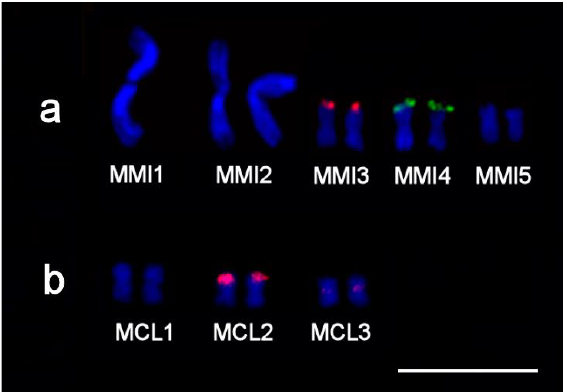
Figure 6. FISH with microdissected DNA probes derived from M. lignano chromosomes ( Mli2 , green signal; Mli3_4 , red signal) on metaphase chromosomes of ( a ) M. mirumnovem and ( b ) M. cliftonensis. Chromosomes were counter-stained with DAPI (blue signal). Scale bar 10 µm.